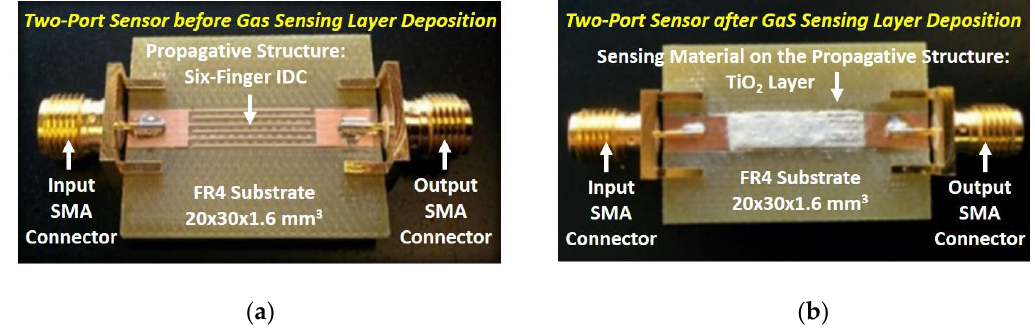
Figure 2. Illustration of the experimental characterization of the developed sensor for oxygen sensing.